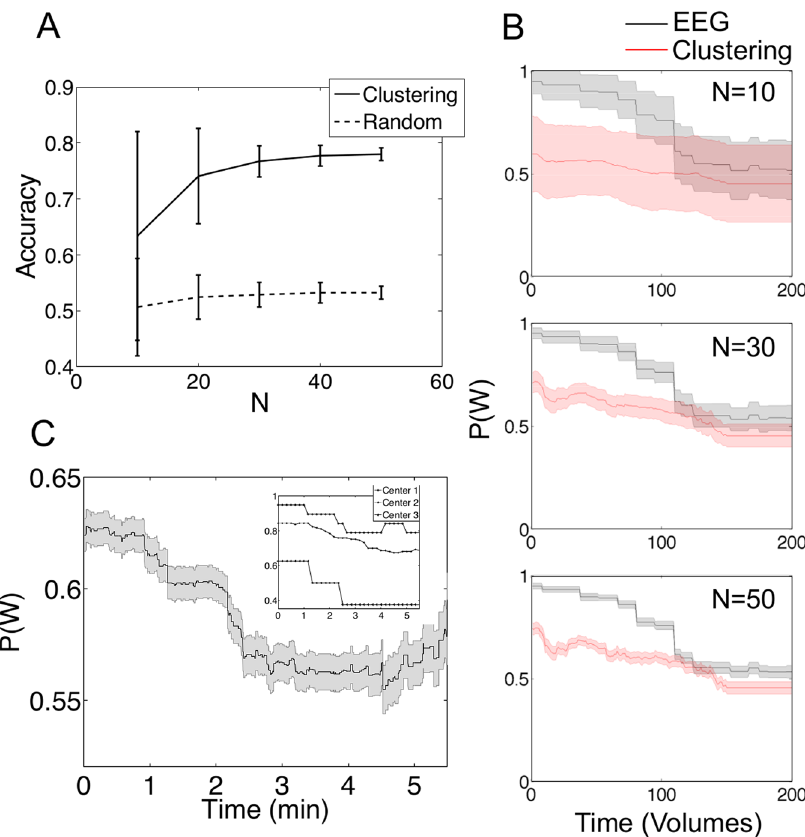
Figure 4. Dynamic connectivity states allow the detection of wakefulness vs. N1 sleep with high accuracy during the first minutes of the scanning session. ( A ) Accuracy (EEG sleep scoring as the reference) for the detection of wakefulness vs. N1 sleep using clustered dynamic connectivity states (7 first minutes only) as a function of sample size (mean ± SD over 100 random subsets of 10 subjects for each sample size). The dashed line indicates the accuracy for the data with randomized sleep stage labels. ( B ) Probability of observing wakefulness based on EEG sleep scoring 32 and using the matched connectivity state (red) as a function of time, for three sample sizes (10, 30 and 50 subjects, respectively; all plots are mean ± SEM). ( C ) Probability of observing the clustered dynamic connectivity state associated with wakefulness in 18 centres from the 1000 Functional Connectomes dataset (mean ± SEM). The inset shows three example centres exhibiting a trend of decreasing wakefulness